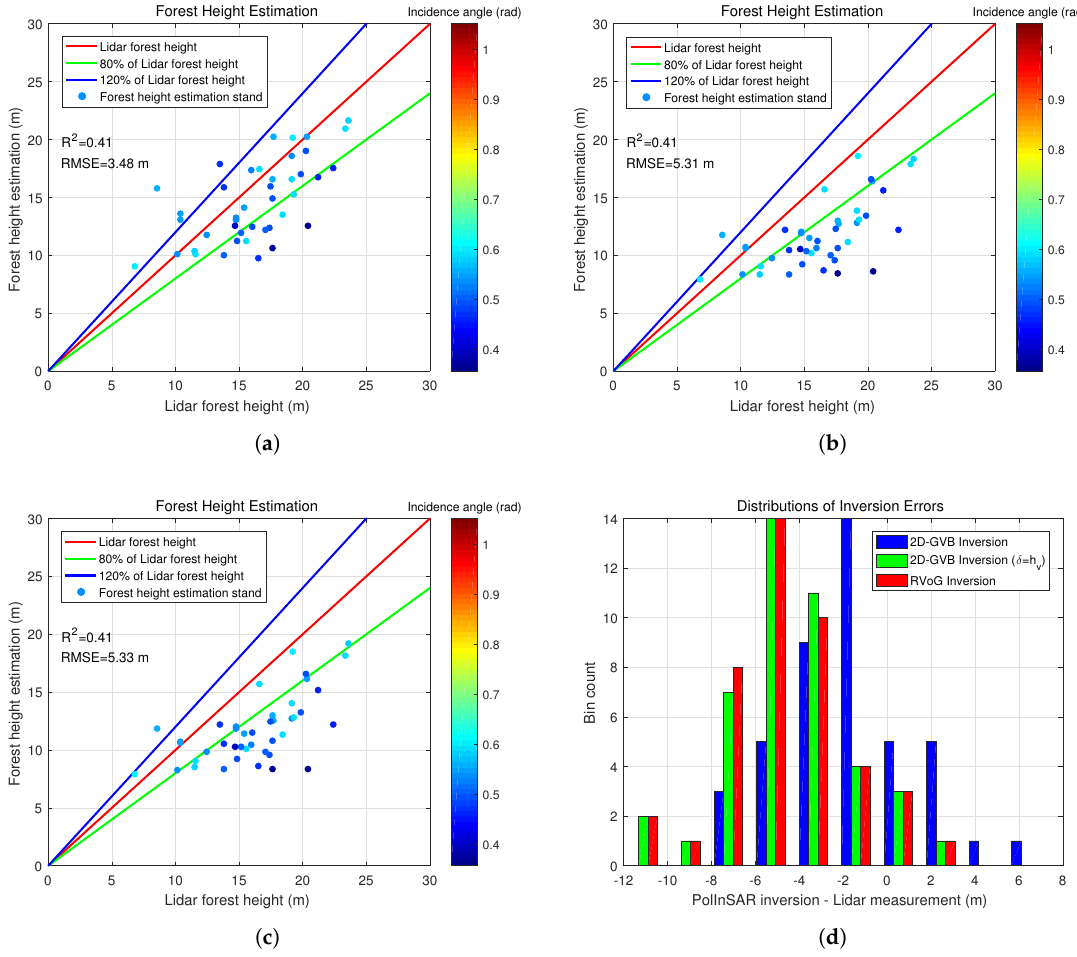
Figure 9. The forest height estimation of validation stands with ( a ) two-dimensional GVB model, ( b ) two-dimensional GVB model with only δ = h v , and ( c ) RVoG model, compared with the LiDAR measurement. These validation stands correspond to those in Figure 8 with an incidence angle less than 0.6 rad. The histogram ( d ) shows the differences between the Pol-InSAR inversion and the LiDAR measurement with the two-dimensional GVB model, two-dimensional GVB model with only δ = h v , and RVoG model, respectively. The stands that are counted in ( d ) correspond to the stands in ( a – c